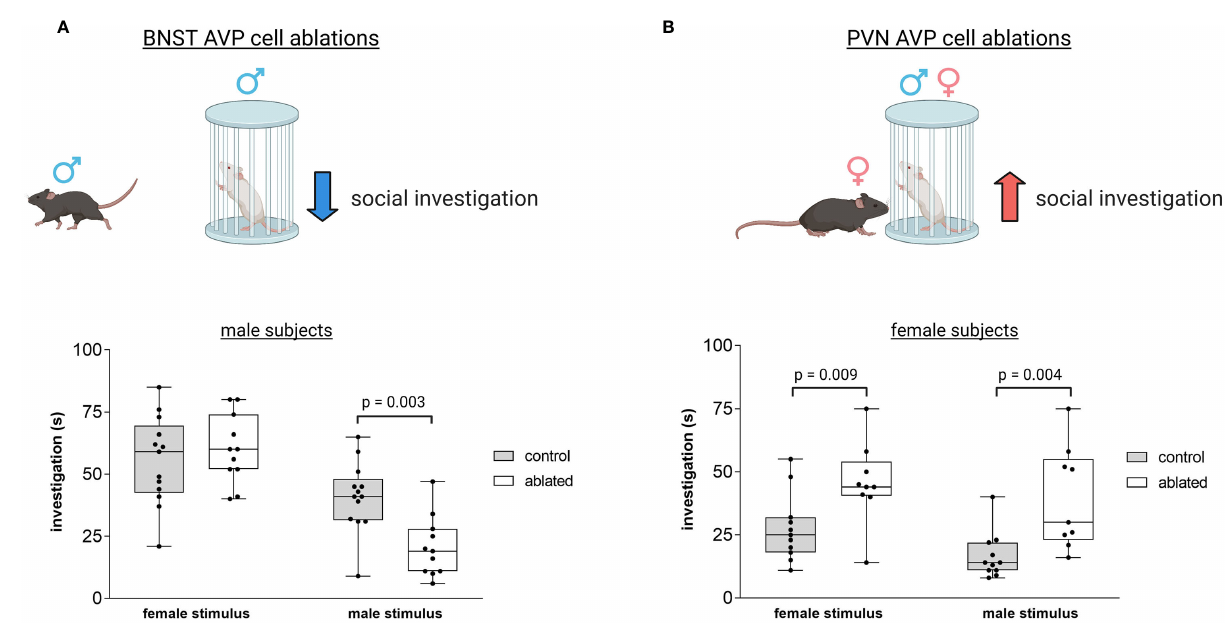
FIGURE 5 Distinct vasopressin cells modulate social investigation in a sex-speci fi c manner . (A) BNST AVP cell ablations in males reduce male-male social investigation [redrawn from (106)]. Boxplot and individual data points of time spent investigating male or female stimulus versus clean empty cage within the three-chamber apparatus. p = 0.003. A signi fi cant interaction was found between genotype and sex (F(1,41) = 4.9, p = 0.03. (B) PVN AVP cell ablations increase female social investigation of male (p = 0.004) and female (p = 0.009) stimuli compared to controls to similar levels as male social investigation [redrawn from (119)]. A signi fi cant interaction was found between genotype and sex (F(1,44) = 5.33, p = 0.02). Created with